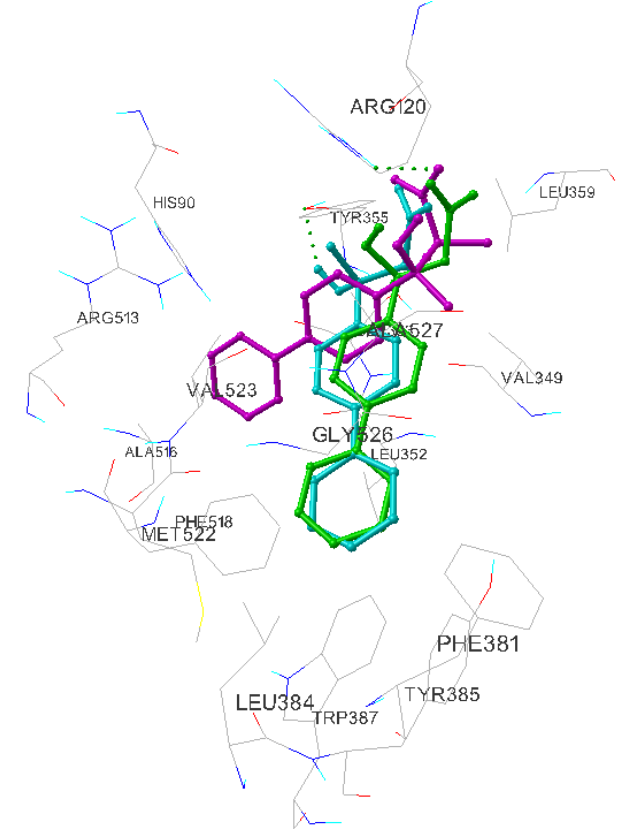
Figure 3. Superimposition of most favorable conformations of compounds 1 (green), 2 (blue) and 3 (magenta) docked into binding site of COX-2 receptor